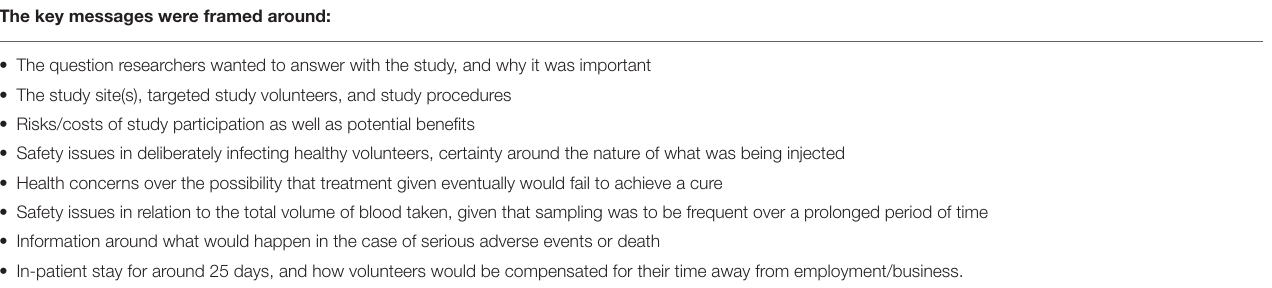
TABLE 2 | Key messages derived by the CAST team for community engagement in the CHMI–SIKA